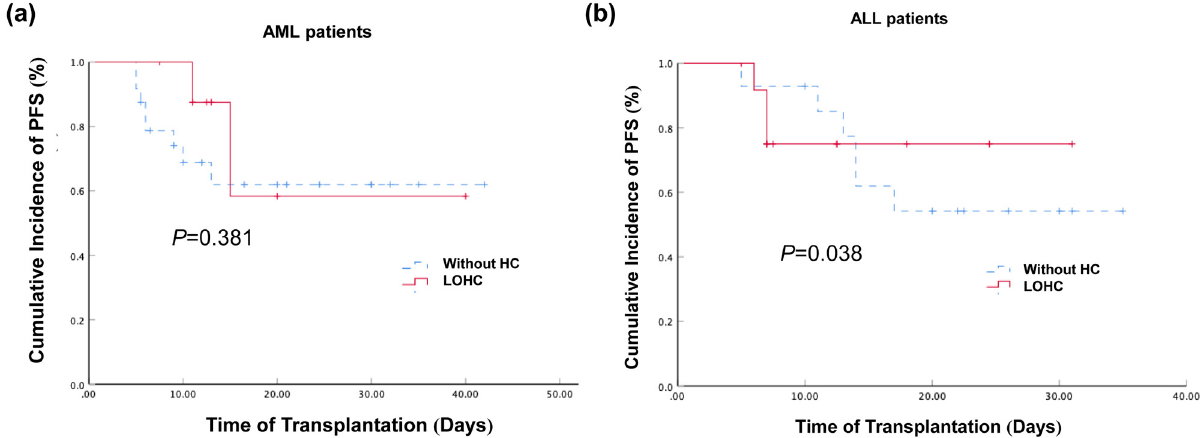
Figure 3: E ff ect of LOHC on the cumulative incidence of PFS in patients with AML and ALL. ( a ) The cumulative incidence of PFS of AML in patients with LOHC and those without HC after haplo - PBSCT were 61.9% ( 95% CI: 40.3 – 83.5% ) and 58.3% ( 95% CI: 35.3 – 81.3% ) , respectively. The P value was 0.381. ( b ) The cumulative incidence of PFS of ALL in patients with LOHC and those without HC after haplo - PBSCT were 54.2% ( 95% CI: 31.7 – 76.7% ) and 75% ( 95% CI: 51.5 – 98.5% ) , respectively. The P value was 0.038.